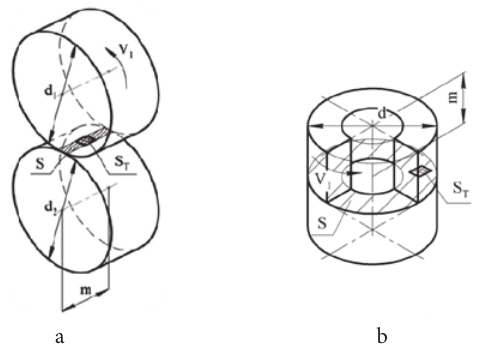
Fig. 1. Kinematic scheme of friction units in the form of rings with cylindrical interaction ( a ) and disks with front interaction ( b ): V – rotational speed of a friction unit, S – area overlapping the surfaces of the friction pair; S T – contact platform in the area overlapping the surfaces of the friction pair; m and d – sizes of composite material elements on the contact